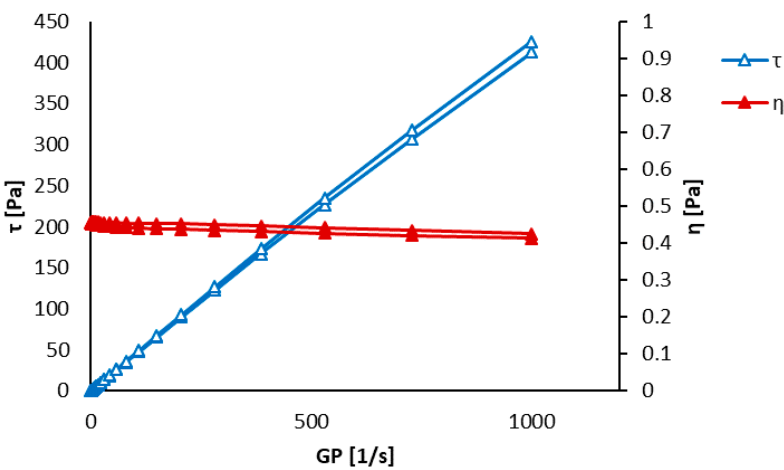
Figure 3. Dynamic viscosity measurement of a clear polycaprolactone precursor after 5 h of the preparation.